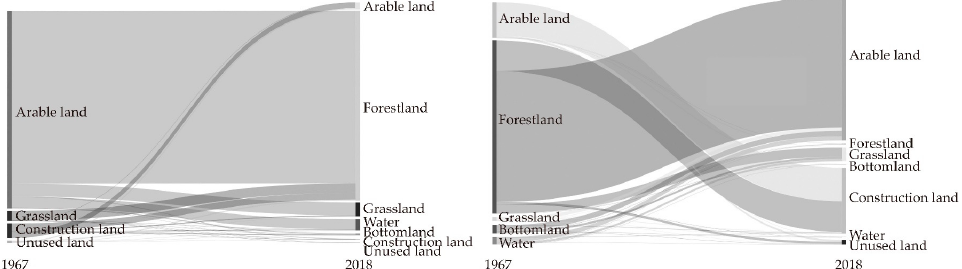
Figure 11. Land use type changes in regions with high habitat quality ( left ) and low habitat quality ( right ).